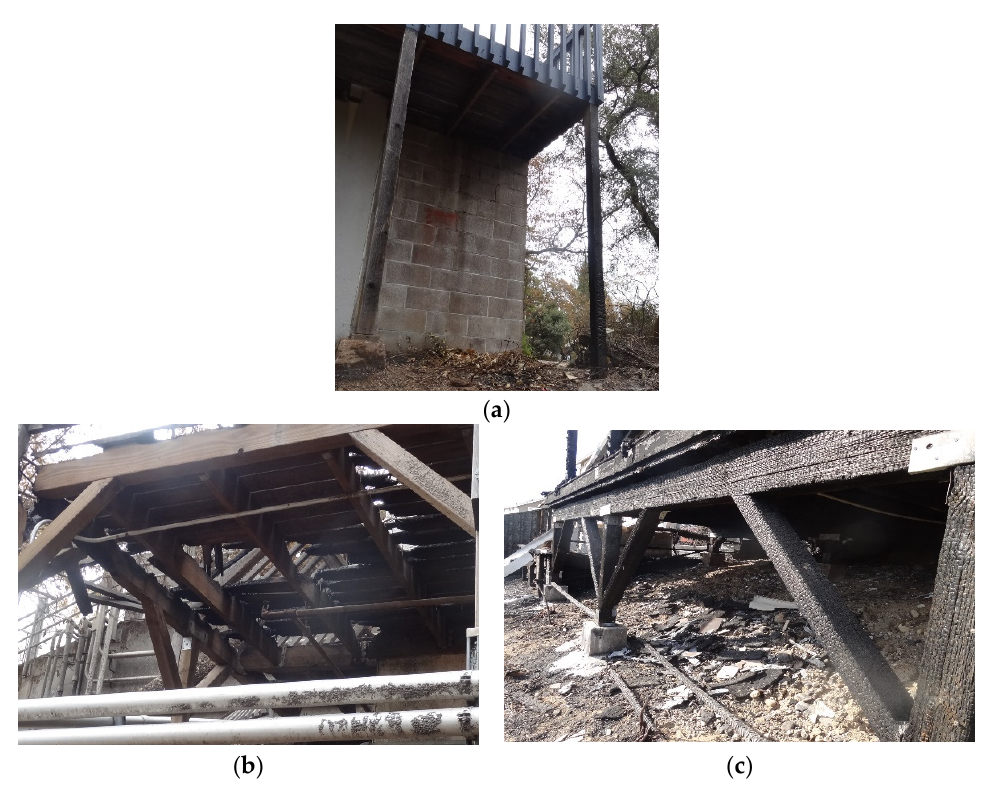
Figure 2. Examples of decks ignited at different locations in the 2020 Glass Fire, ( a ) ignition at the right footer (suppressed by first-responders during the event), ( b ) likely above-deck ignition because of uncharred joists, and ( c ) ignition of combustibles near/below the deck and fire spread to the deck. (Images taken during IBHS’s post ‐ event investigation).